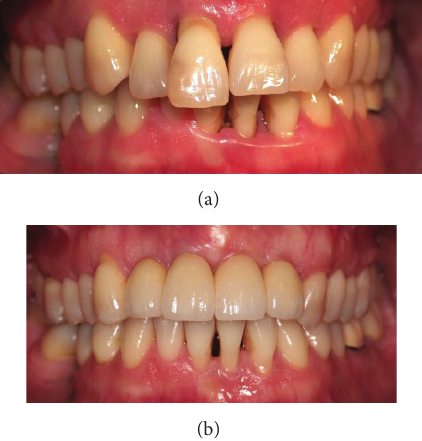
Figure 22: Before and after image depicting the patient upon presentation (a) and the patient at five-year follow-up